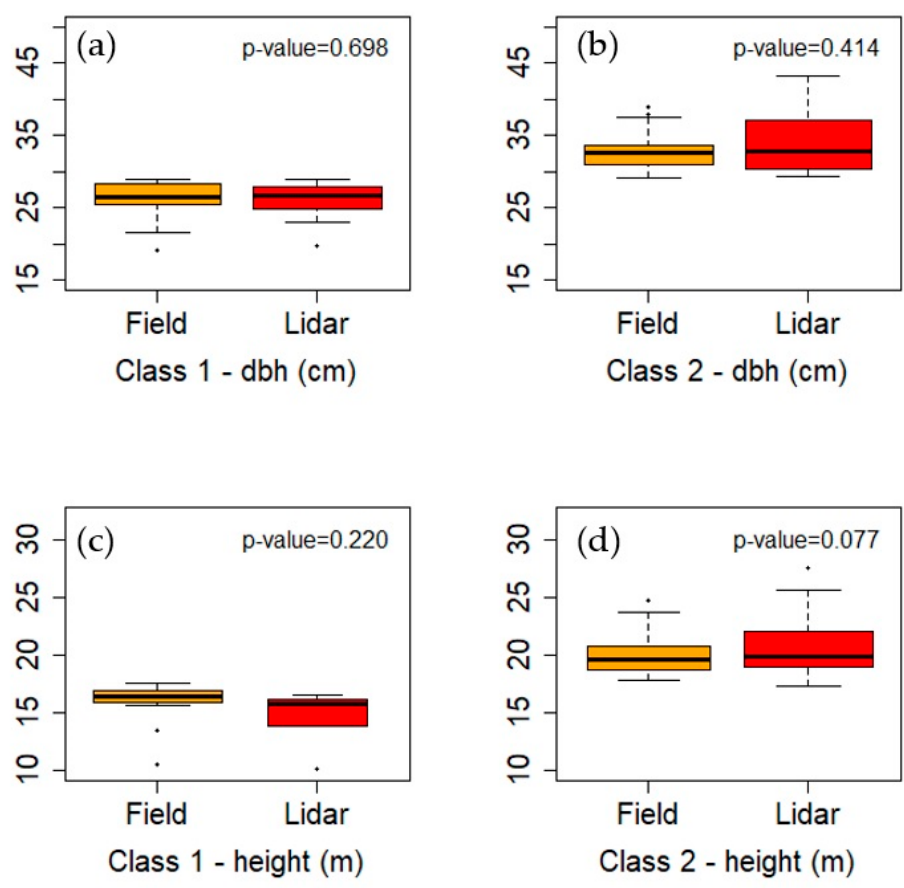
Figure 7. Boxplot of classes of the dbh (field and Lidar) and Height (field and Lidar) in Integrated Crop-Livestock-Forest System (ICLF) in Brazil. ( a ) Class 1 dbh; ( b ) Class 2 dbh; ( c ) Class 1 height; ( d ) Class 2 height.